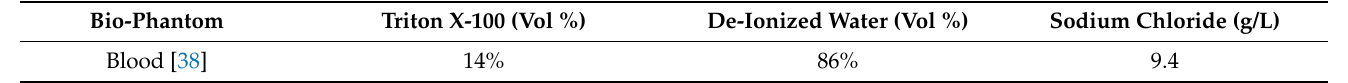
Table 2. Ingredients and quantities for bio-phantom material.